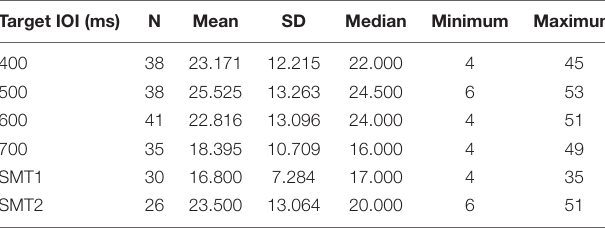
TABLE 4 | Number of drum hits made by infants in each trial